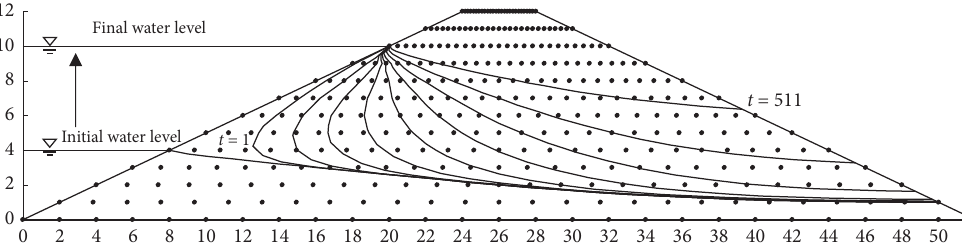
Figure 7: The phreatic line differences with time